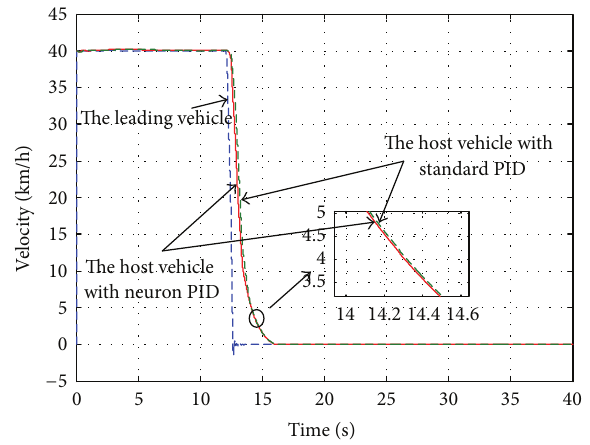
Figure 7: The vehicle velocity.